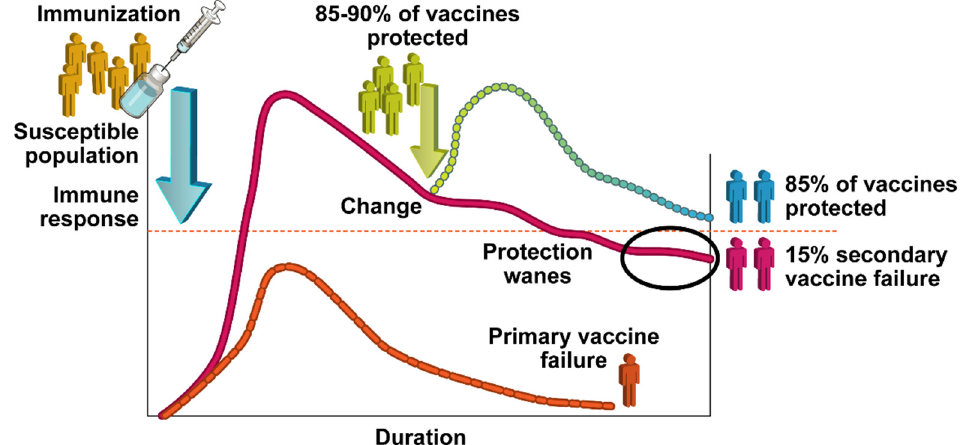
Figure 1. Representation of vaccine failures. After immunization, a humoral response is generated. A primary vaccine failure occurs when the immune response fails to generate sufficient protection levels, or titers (shown in orange). The immune response level sufficient for protection is shown as the dashed red line. A secondary vaccine failure occurs when protection levels wane.